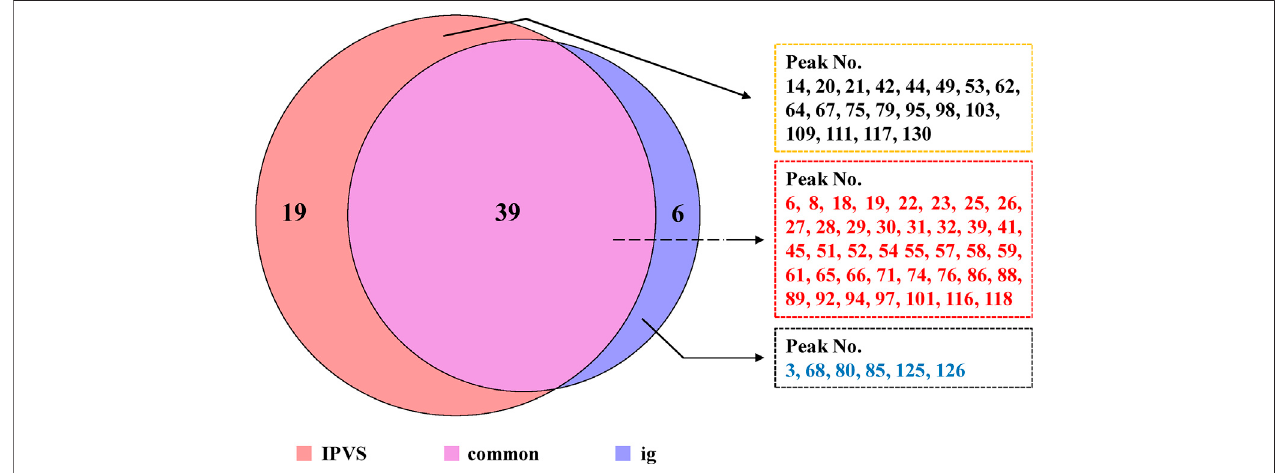
FIGURE 4 | Comparison of the absorbed components between intestinal perfusion with venous sampling (IPVS) and the intragastric (IG) method.